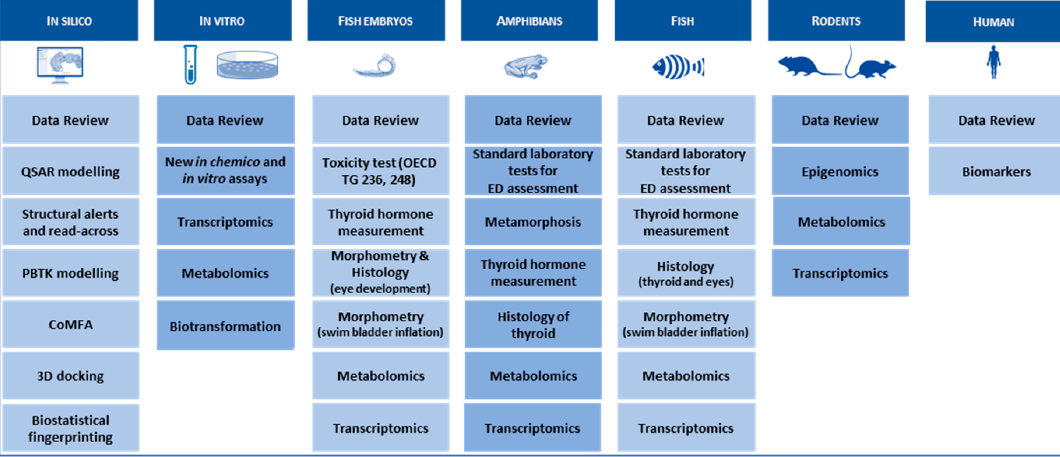
Figure 4. ERGO data warehouse. Via a combination of existing data from data reviews and data generated in ERGO WPs, ERGO will develop a comprehensive data warehouse composed of different kinds of cross-vertebrate class, in silico, in vitro, in vivo samples and cell-lines samples combined with many state-of-the-art analytical methods.